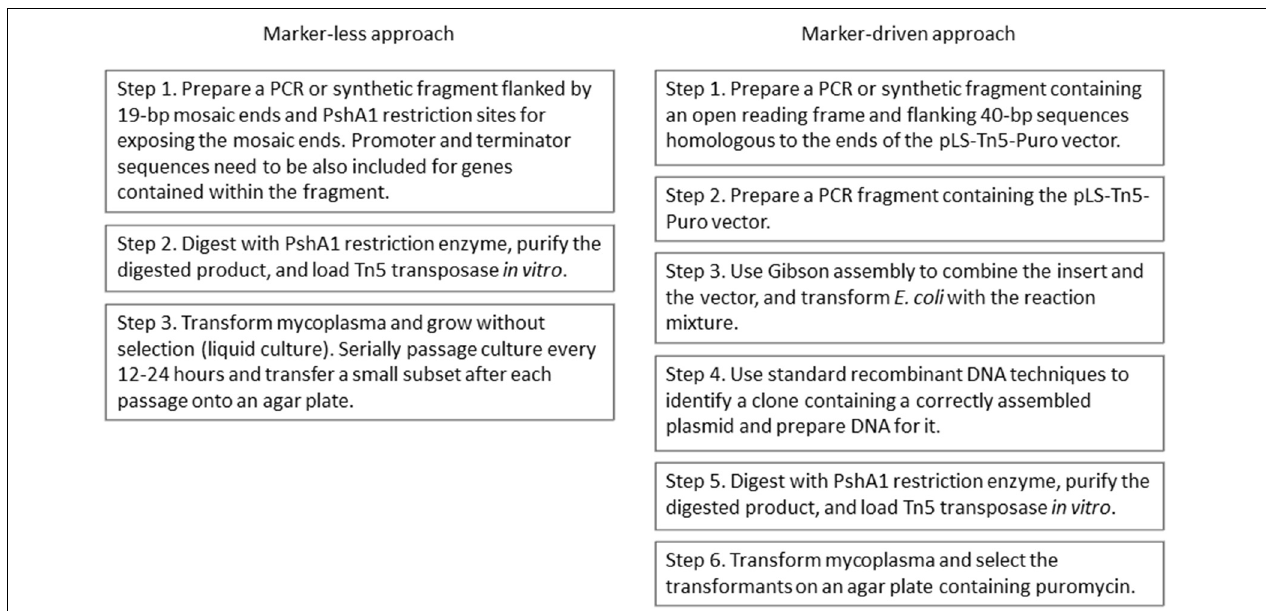
FIGURE 3 | Flow charts of procedures for complementation of mycoplasma mutants using the marker-less approach and the marker-driven approach.